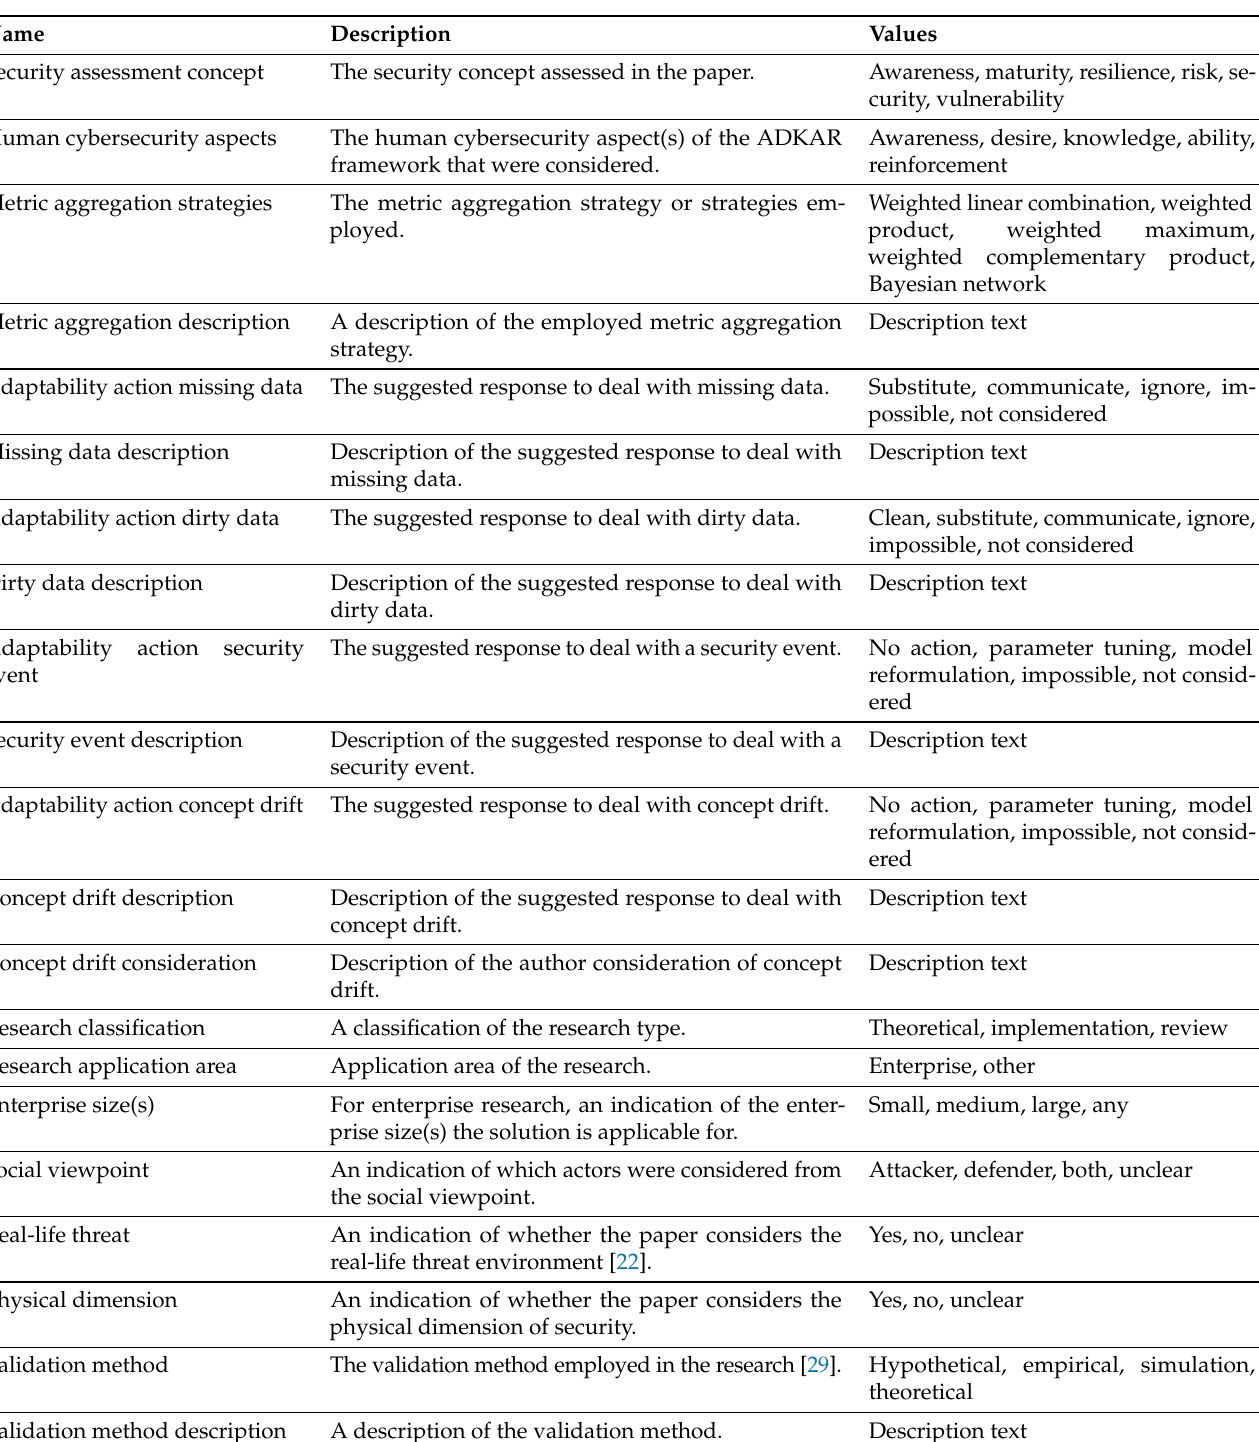
Table A1. The data items extracted from the 60 inclusions in our